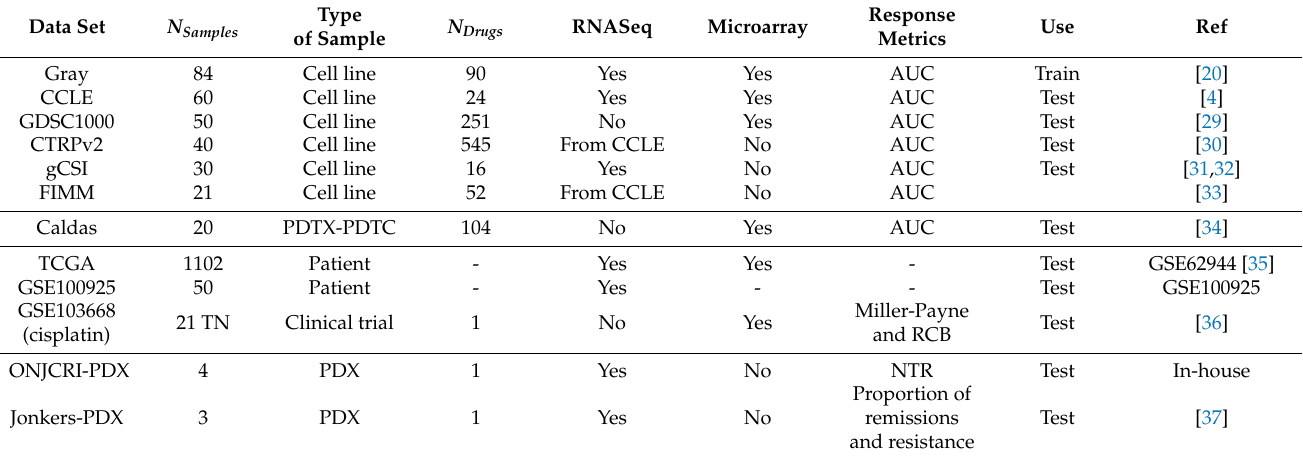
Table 1. Training and test datasets used to derive and test the drug efficacy signatures TN: triple- negative; AUC: area under the dose-response curve; RCB: residual cancer burden; PDTX-PDTC: patient-derived tumor xenografts and PDTX-derived tumor cells; NTR: Normalized tumor response. Note that N Samples represents the total number of cell lines/tissue samples in each study, however, not all of these were used for drug screening and some cell lines did not have both RNA-seq and drug data.